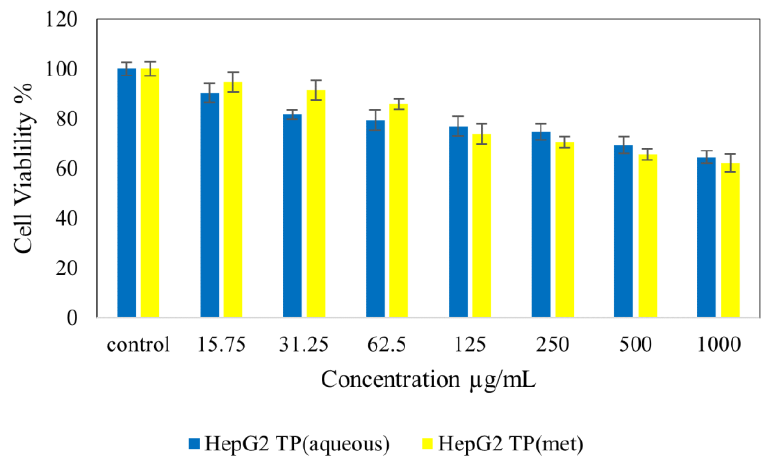
Figure 5. Cytotoxic activity of extracts against normal HepG2 cells at 48 h.